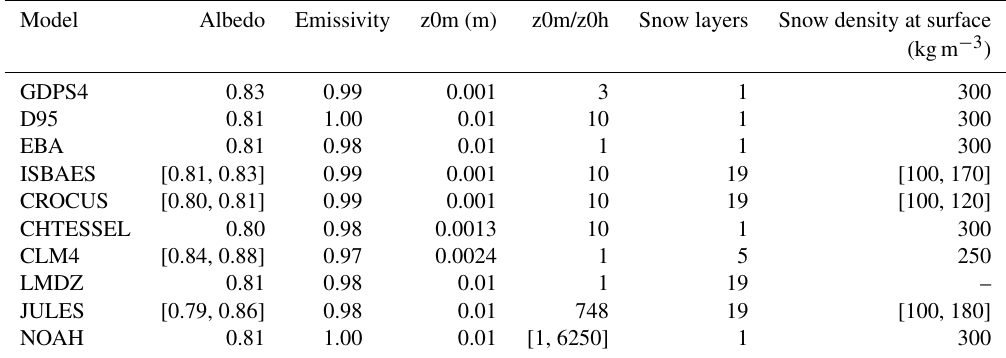
Table 3. Range of variation of model surface parameters for XP0. The values in square brackets indicate the values taken by a parameter when it is calculated by the model, while the single values are fixed during the simulation.